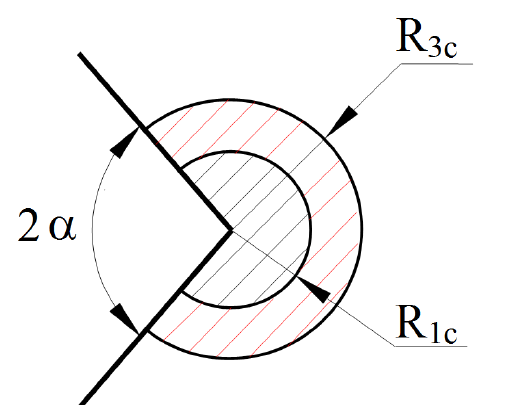
Figure 2: Control volumes for V-shaped notches under tension and torsion